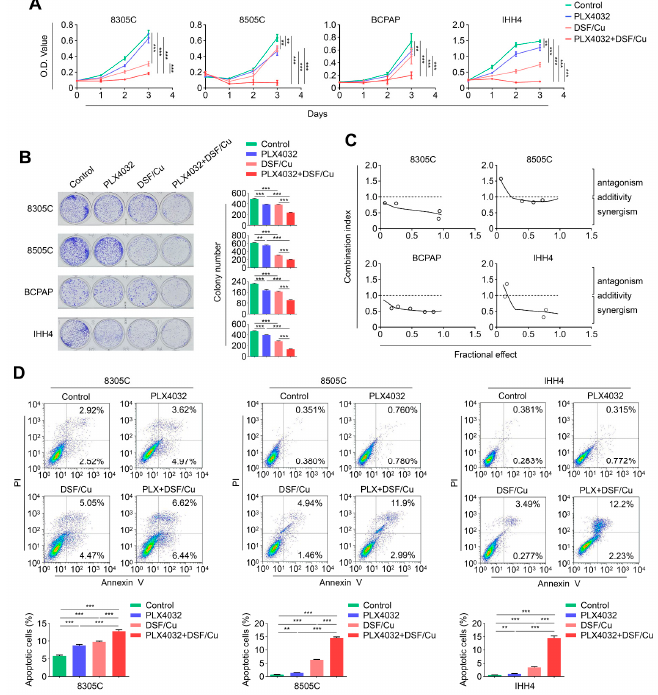
Figure 4. The combination of DSF/Cu and PLX4032 has a synergistic antitumor effect in BRAF V600E - mutated thyroid cancer cells. ( A ) The indicated cells were treated with 100 nM DSF/Cu (1:1) and 2 μ M PLX4032, individually or in combination, for 48 h, and their effects on cell proliferation were then assessed by MTT assay. ( B ) The above cells were treated with 50 or 40 nM DSF/Cu (1:1) and 1 μ M PLX4032, individually or in combination, for 8–10 days, and their effects on colony formation was further evaluated. The left panels show the representative images of colony formation. Quantitative analysis of colony numbers is presented in the right panels. ( C ) Dose–effect relationship between DSF/Cu and PLX4032 for antiproliferative effect was analyzed after 48 h of exposure in the indicated cells by the Chou–Talalay dose–effect method, and combination index (CI) values were calculated. CI < 1, CI = 1, and CI > 1 represent synergism, additivity and antagonism of these two agents, respectively. ( D ) BRAF V600E -mutated thyroid cancer cell lines 8305C, 8505C and IHH4 were treated with 0.5 µ M DSF/Cu (1:1) and 2 µ M PLX4032, individually or in combination, for 48 h, and their effects on cell apoptosis were analyzed by flow cytometry. Data presented as means ± SD. ** p < 0.01; *** p <